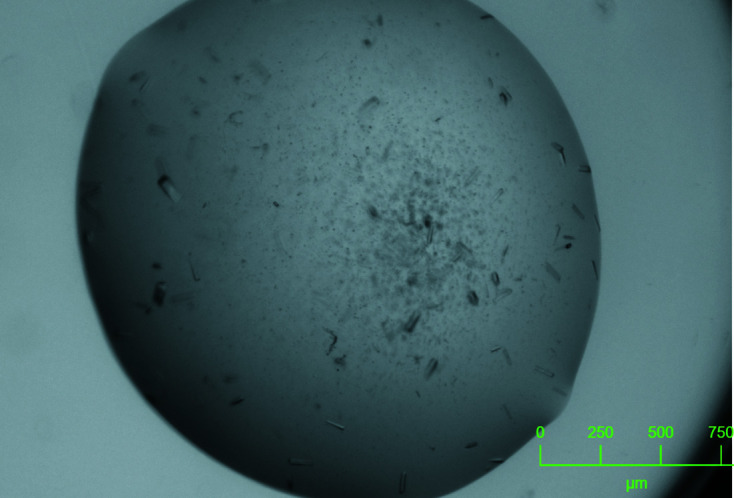
Crystals of Ssr4.